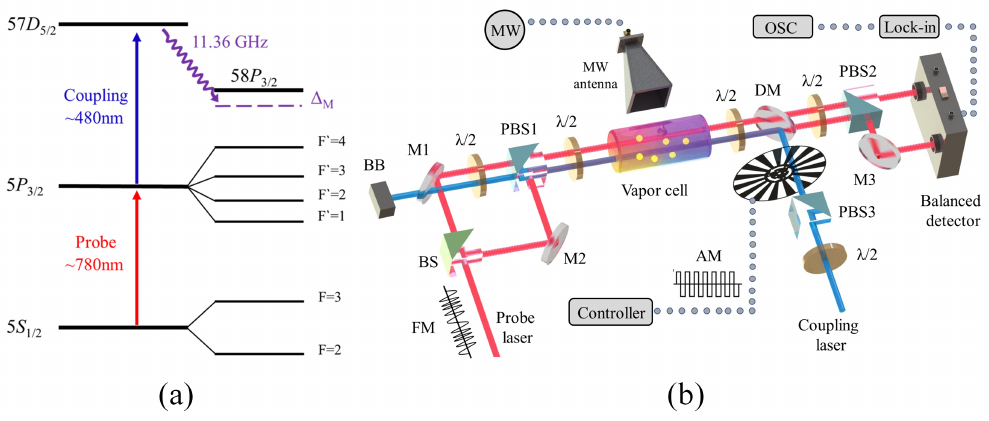
Figure 1. ( a ) illustration of a four-level system of 85 Rb; ( b ) sketch of the experiment setup. MW, microwave source; BB, beam block; BS, beam splitter; λ /2 , half-wave plate; PBS, polarizing beam splitter; M, mirror; DM, dichroic mirror; Lock-in, lock-in amplifier; OSC, oscilloscope; AM, amplitude modulation; FM, frequency